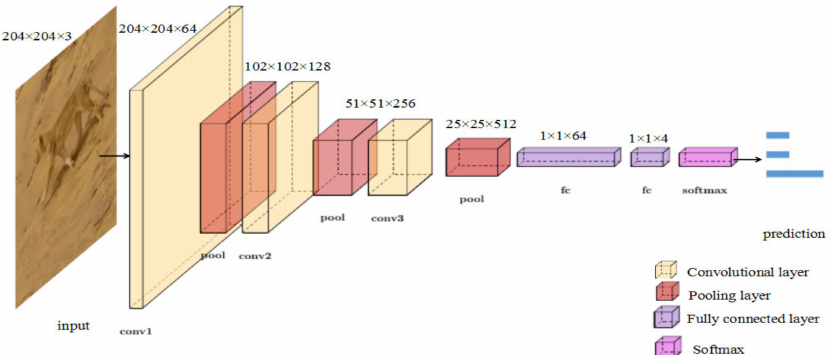
Figure 4. Illustration of Tiny Visual Geometry Group